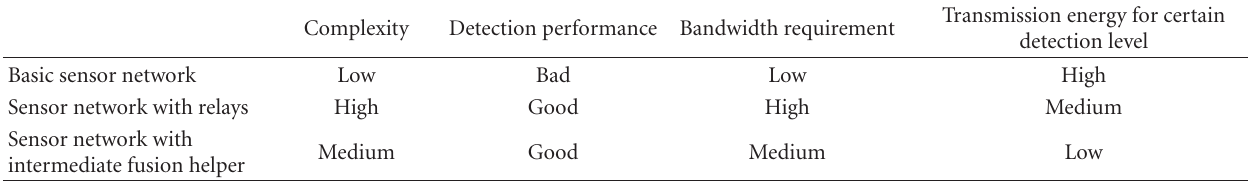
Table 1: Comparison of three sensor